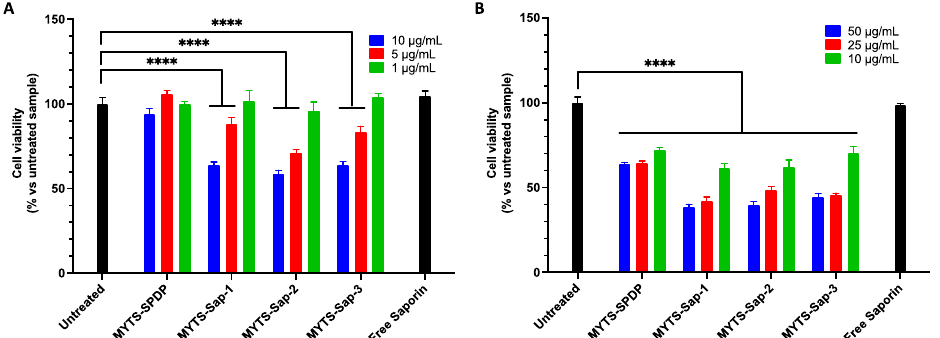
Figure 6. MTT assay performed incubating MYTS-SPDP, MYTS-Sap-1, MYTS-Sap-2 and MYTS-Sap-3 at concentrations of ( A ) 1, 5 and 10 µg/mL, with HeLa cells, and ( B ) 10, 25 and 50 µg/mL, with U87 cells, for 24 h. For free Saporin samples (black), the maximum Saporin concentration tested in MYTS-containing samples was used (10 µg/mL MYTS-Sap-3 for HeLa and 50 µg/mL MYTS-Sap-3 for U87). **** p < 0.0001 vs. untreated (black).